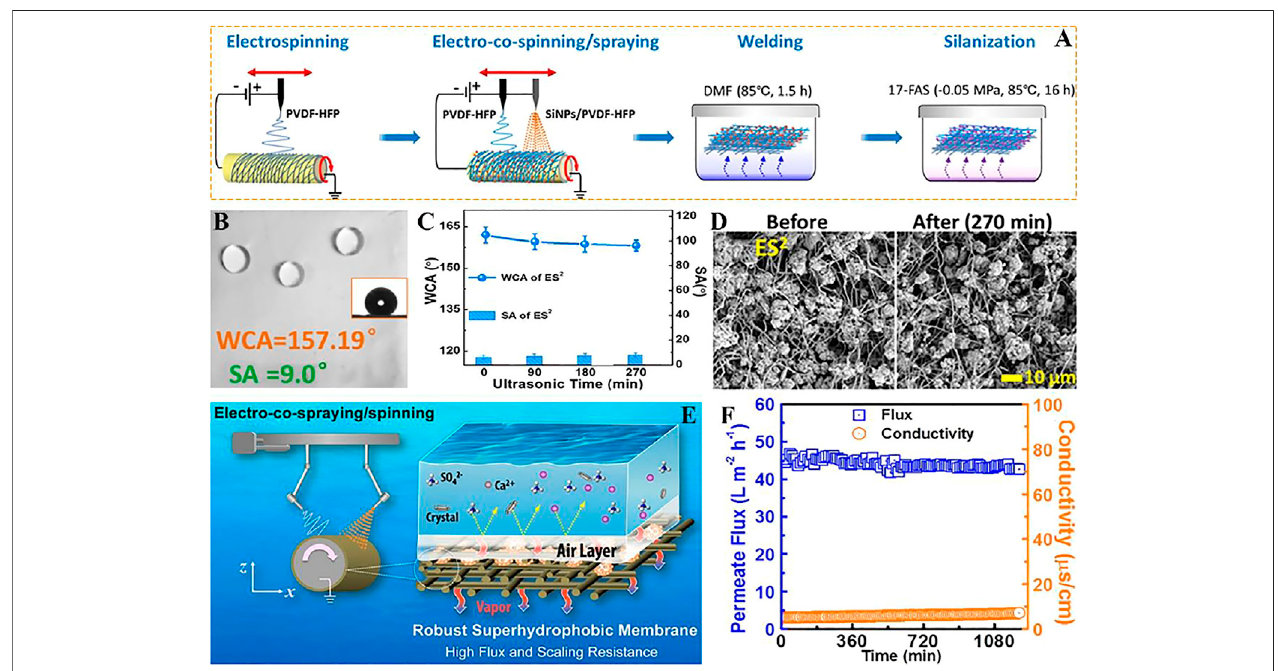
FIGURE 9 | (A) Schematic diagram of the ES2 process for fabricating robust superhydrophobic membrane. (B) The WCA and SA of robust superhydrophobic membrane. (C) WCA and SA of the r-SH membranes after different durations of ultrasonication. (D) SEM surface morphology of ES2-derived robust superhydrophobic membrane 270 min before (left) and after (right) ultrasound. (E) The mechanism of membrane distillation. (F) Vapor fl ux and conductivity of superhydrophobic electrospun fi ber membrane (Su et al.,